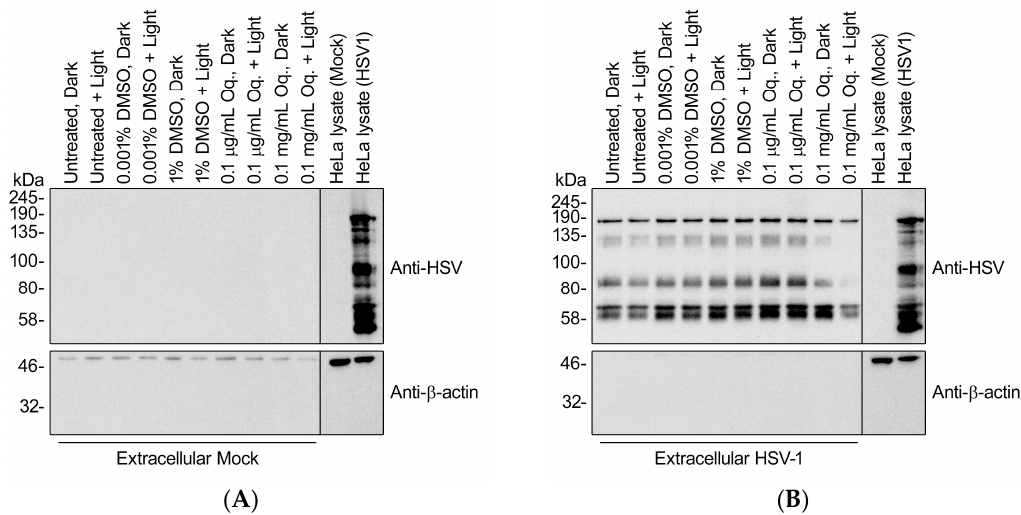
Figure 8. High doses of Orthoquin inhibit detection of HSV-1 structural proteins. Culture supernatants from mock-infected HeLa cells ( A ) or HSV-1-infected HeLa cells ( B ) were processed by differential centrifugation and exposed to 0.1 µg/mL or 0.1 mg/mL Orthoquin, or DMSO vehicle control, or mock-treated for 10 min and exposed to a 65 W LED light in clear (light) or black (dark) tubes. Following treatment, HSV-1 particle preparations were subjected to SDS-PAGE and immunoblotting with a rabbit polyclonal pan-anti-HSV1 antibody that detects viral structural proteins. Uninfected and infected HeLa cell lysates were included as controls for HSV-1 antigen detection.